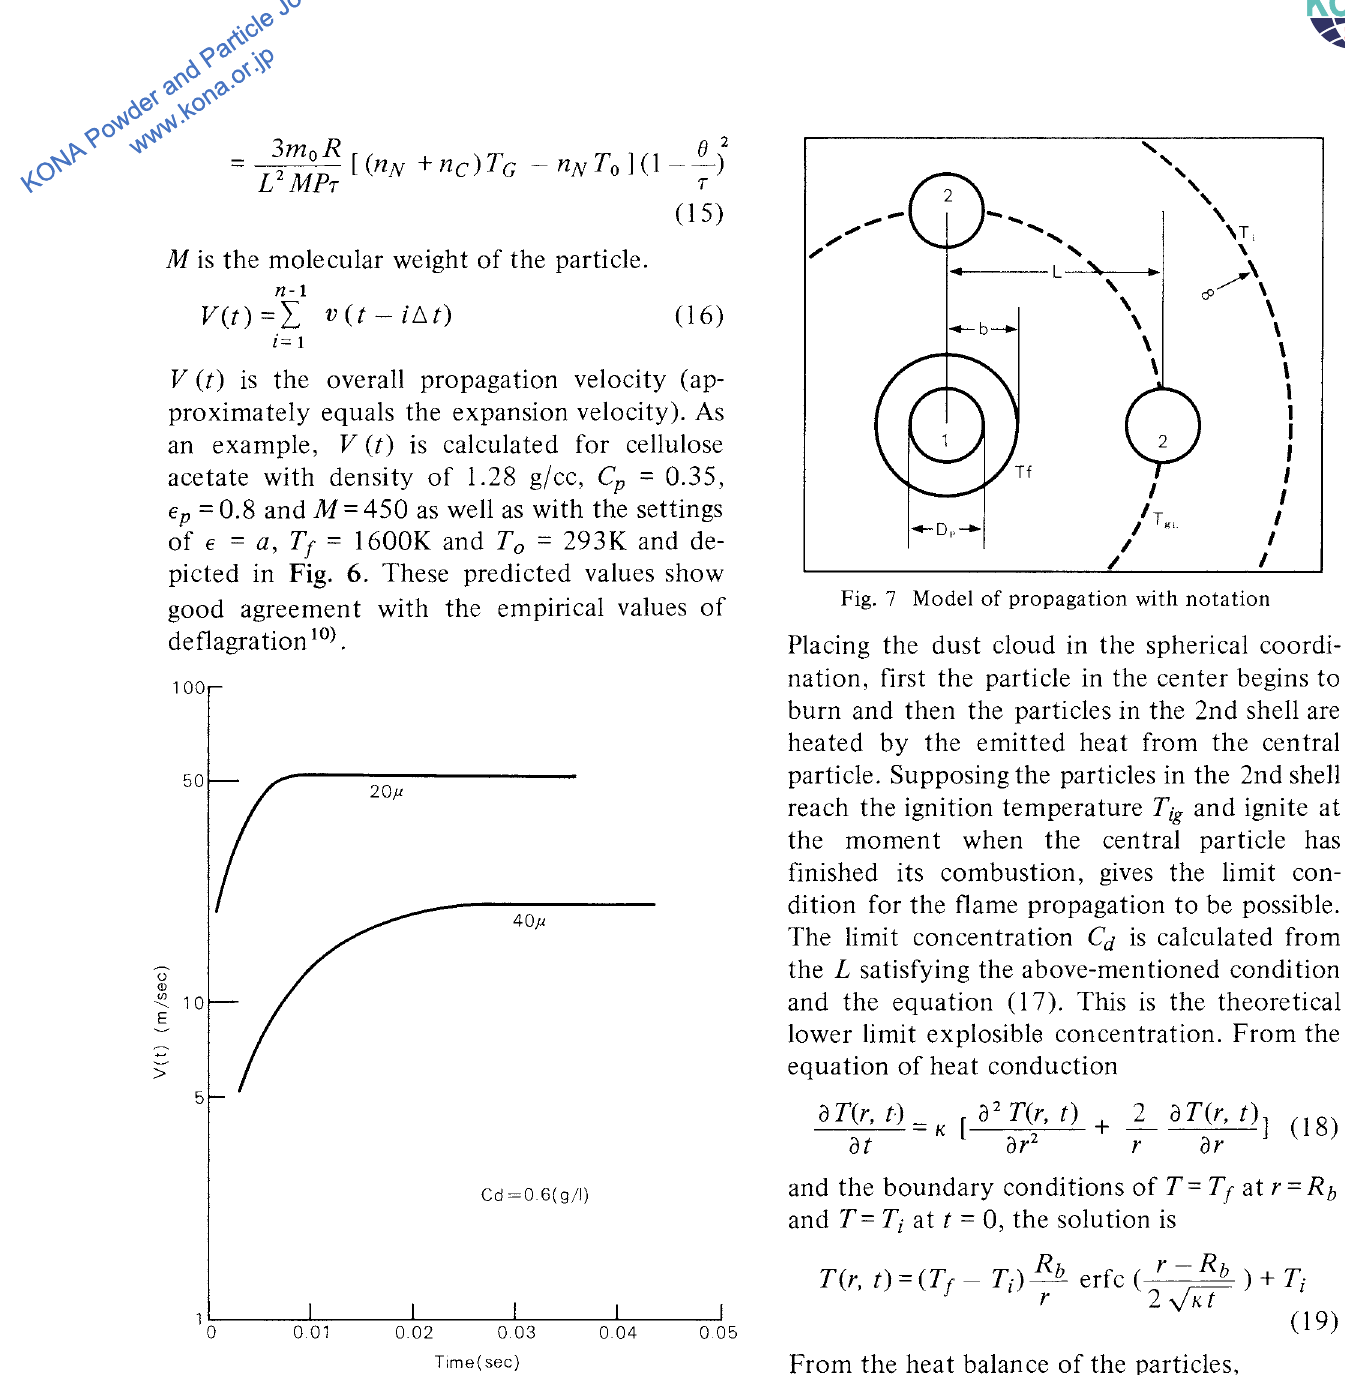
Fig. 6 Overall expansion velocity